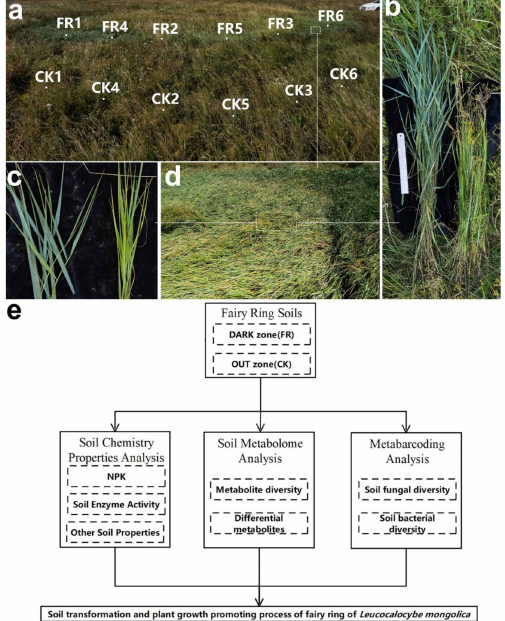
Figure 1. Apparent morphology of fairy rings and technical route of the study methods. ( a ) Fairy ring landscape and soil sampling point in this study, FR1-6 mean sampling point in DARK zone; CK 1-6 sampling point in OUT zone. ( b ) Comparison of plant height between DARK ( upper ) and OUT ( lower ) zones. ( c ) Comparison of leaf color between DARK ( left ) and OUT ( right ) zone; ( d ) Lush vegetation inside the DARK zone. ( e ) The technical route of this